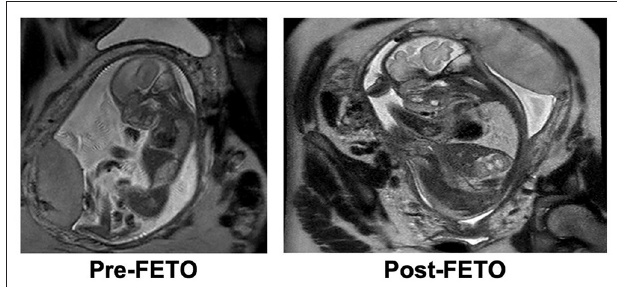
FIGURE 2 | Increase in observed-to-expected lung volume following prenatal intervention with Fetoscopic Endoluminal Tracheal Occlusion.